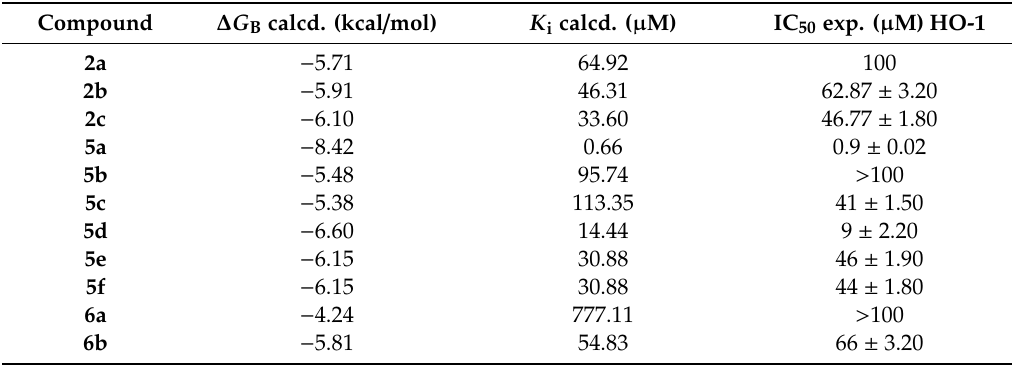
Table 2. Docking results for the studied molecules 2a – c , 5a – f, and 6a , b